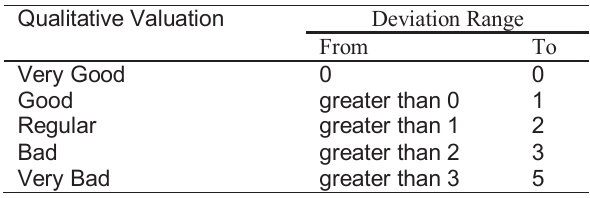
Table 8. Qualitative valuation range deviation